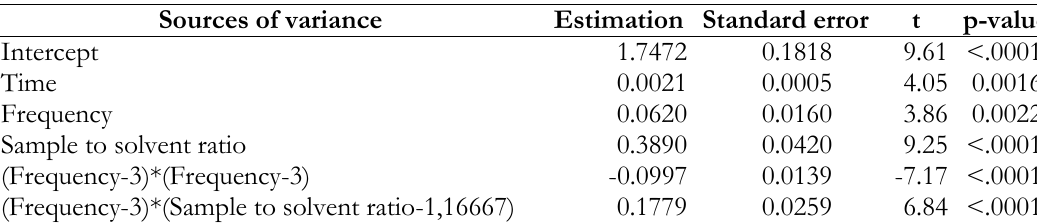
Table II. Estimation of coefficient